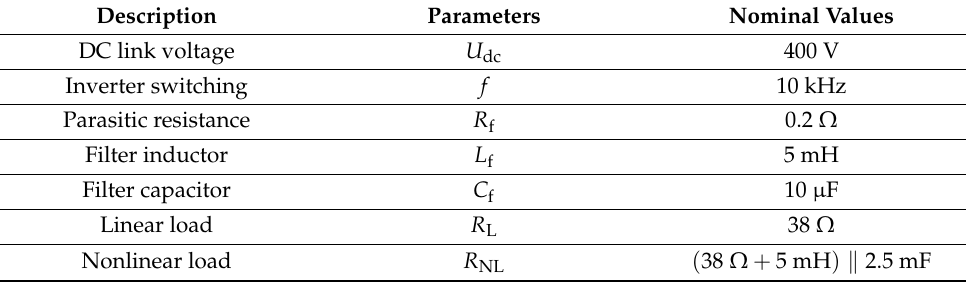
Table 1. System electrical parameters [56].